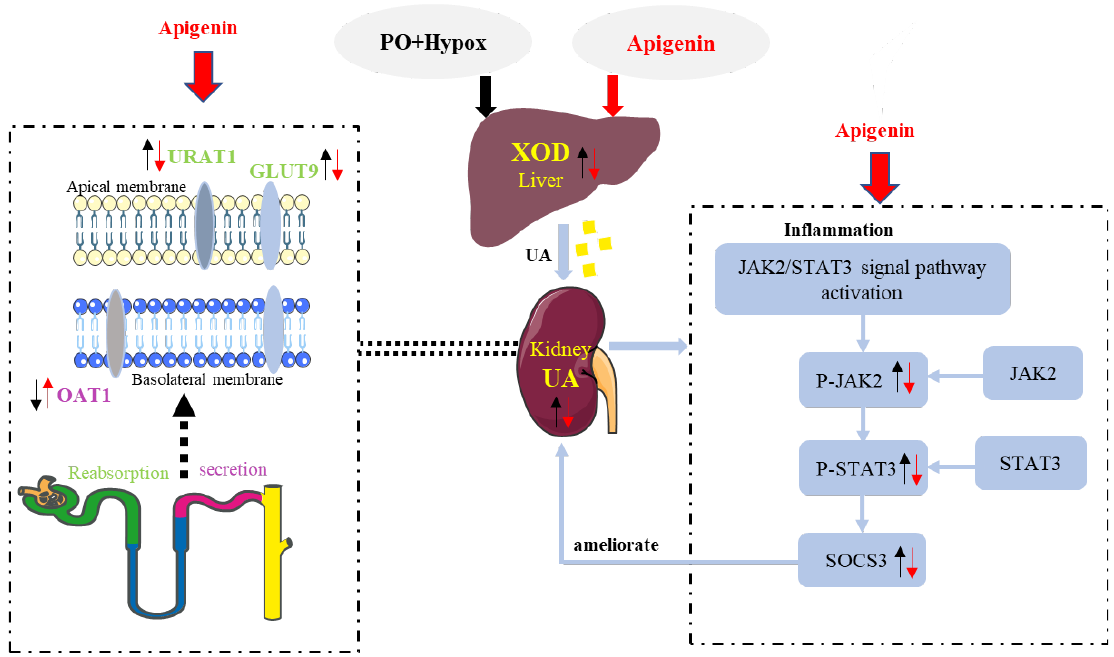
Figure 9. Apigenin may ameliorate HUA and renal injury through regulation of UA metabolism and the JAK2/STAT3 signaling pathway. The black arrow indicates the changes of biomarkers in HUA mice induced by PO and Hypox, and the red arrow indicates the changes of biomarkers in HUA mice after apigenin intervention.